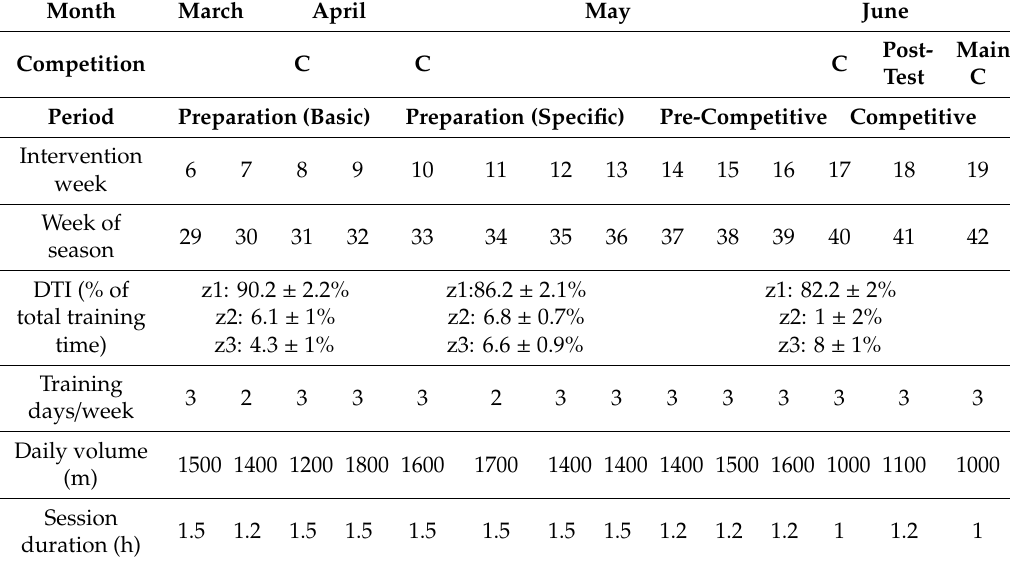
Table 2. Macrocycle 2